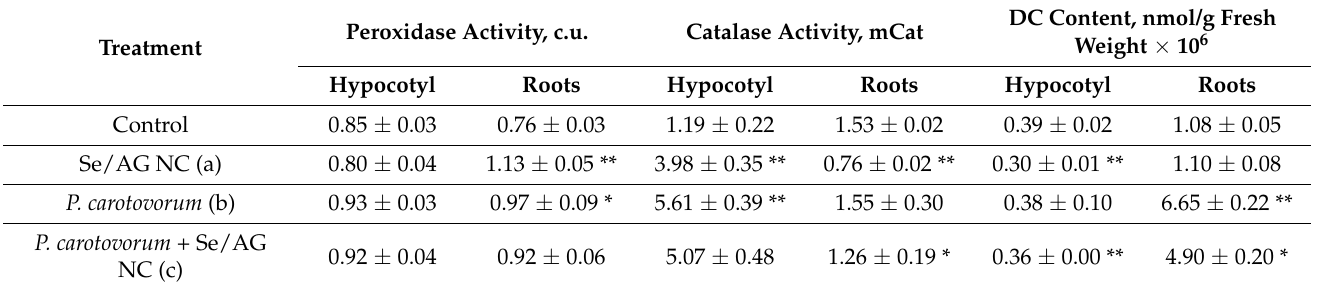
DC Content, nmol/g Fresh Weight × 10 6